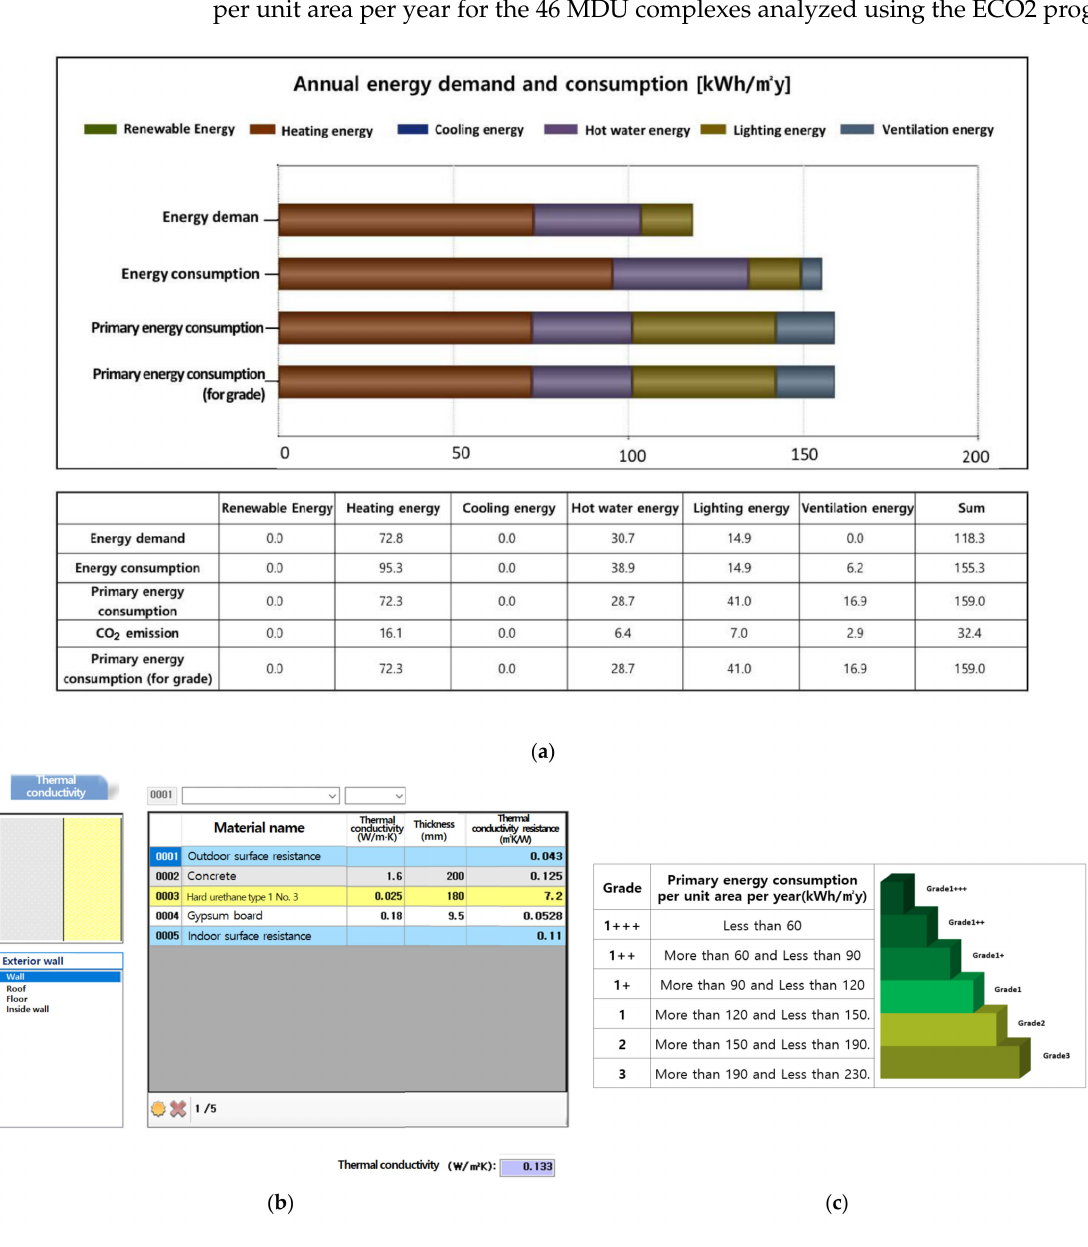
Figure 5. Input and output of ECO2 program; ( a ) Analysis results: annual energy demand, energy consumption, and primary energy consumption ( b ) Input of external wall insulation ( c ) primary energy consumption per unit area per year by building energy efficiency